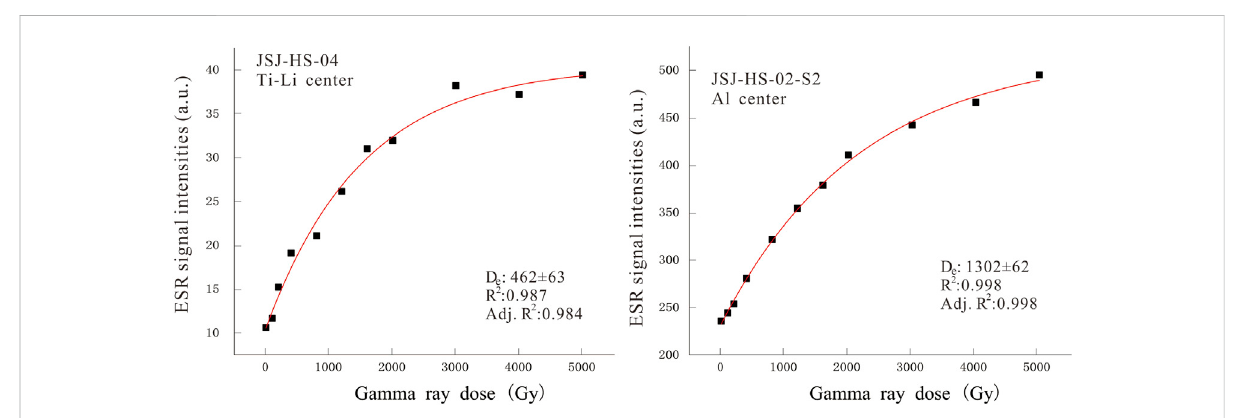
FIGURE 11 Dose response curves of the Ti-Li center (option A) of JSJ-HS-04 and the Al center of